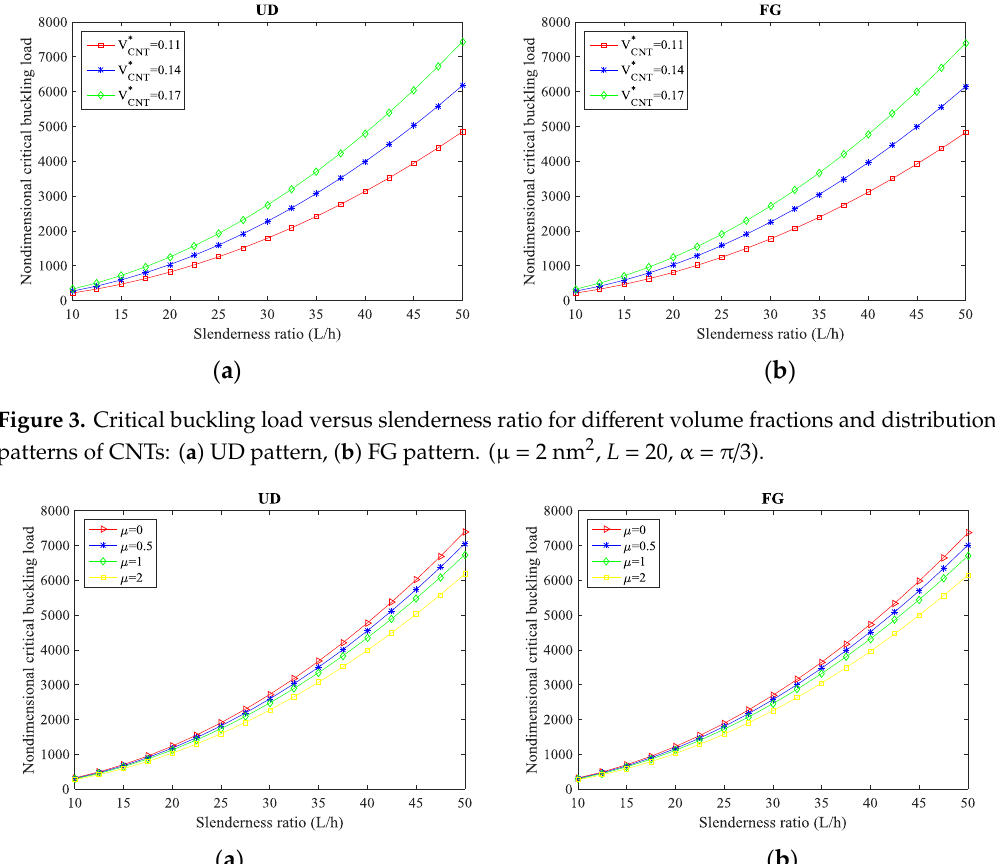
Figure 4. Critical buckling load versus slenderness ratio for different nonlocal parameters and distribution patterns of CNTs: ( a ) UD pattern, ( b ) FG pattern. ( L = 20, α = π / 3, V ∗ = 0.14